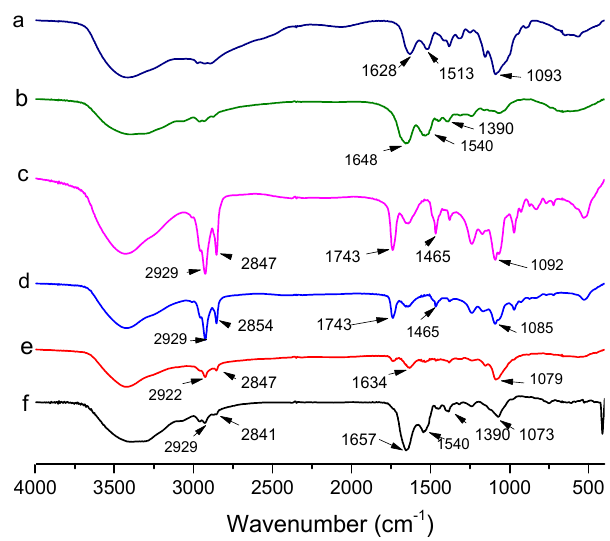
Figure 4. Fourier transform infrared spectra of different samples. a: CH, b: LF, c: blank liposome, d: AST-Lip, e: CH-AST-Lip and f: LF-AST-Lip.